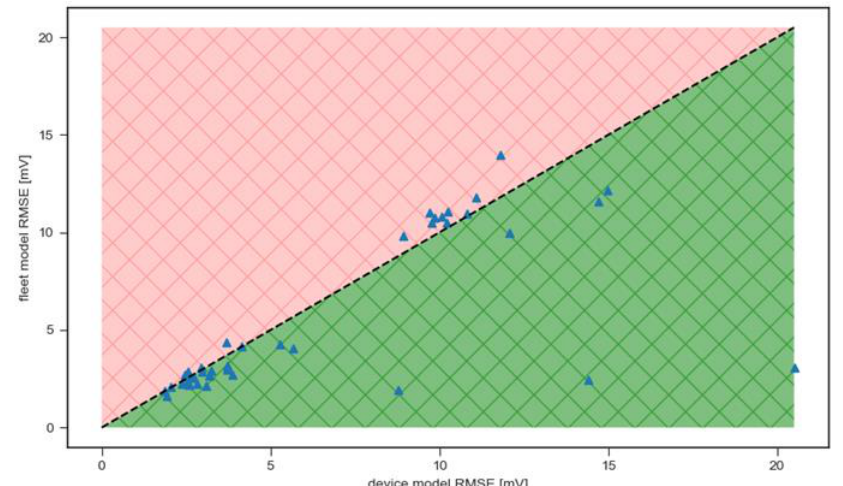
Figure 9. Comparison of RMSE of validation sections after training with all fleet data (approach 1.) versus training with data from a selected device (approach 2.). The errors could be reduced for most sections.